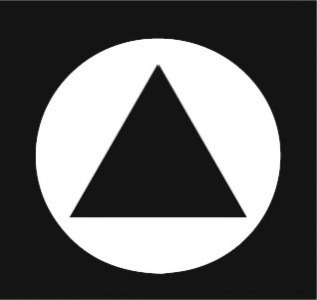
The sticker used as a target for distance tracking. Its dimensions are 37 mm wide by 35 mm high.